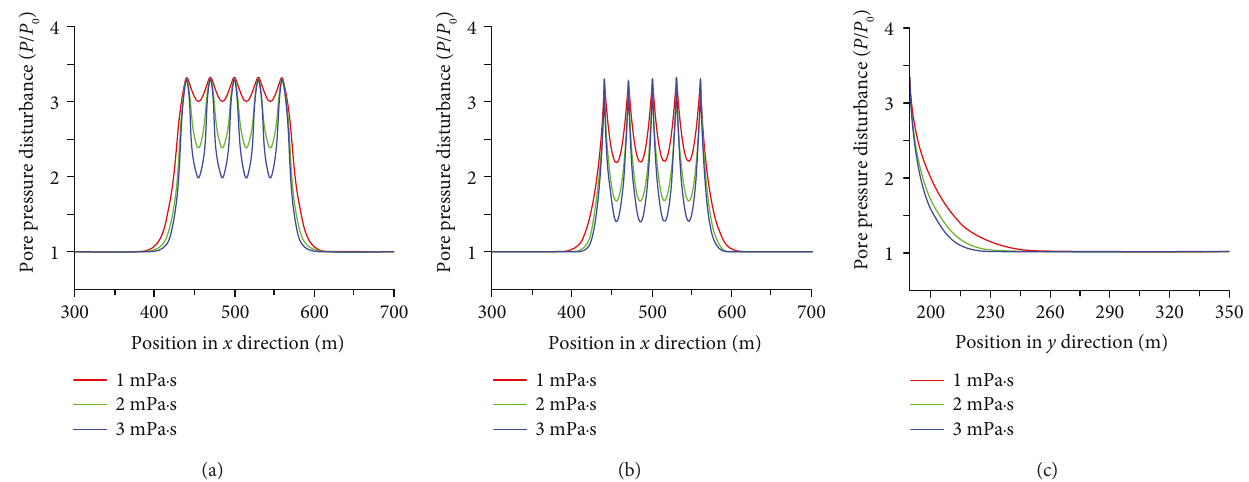
Figure 5: Pore pressure disturbance for di ff erent viscosities at t = 4 h: (a) for data output line 1, (b) for data output line 2, and (c) for data output line 3.